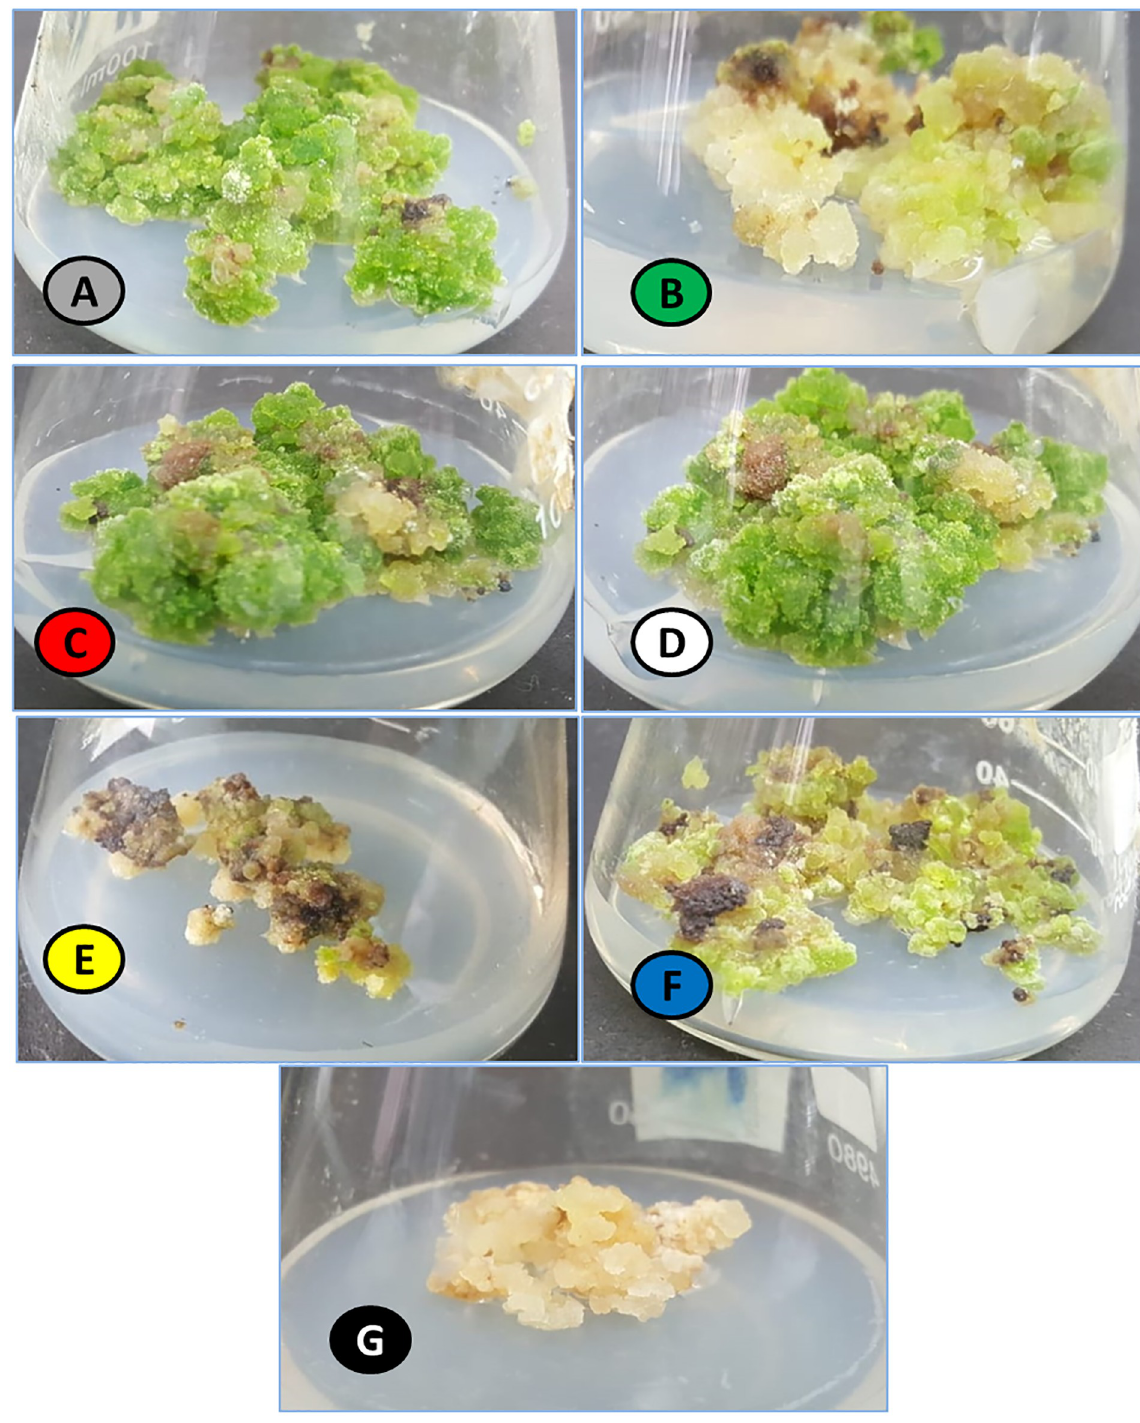
Fig 1. Morphological variation in callus culture placed under different monochromatic lights. (A = . Control; B = Green; C = Red; D = White; E = Yellow; F = Blue; G = Dark).